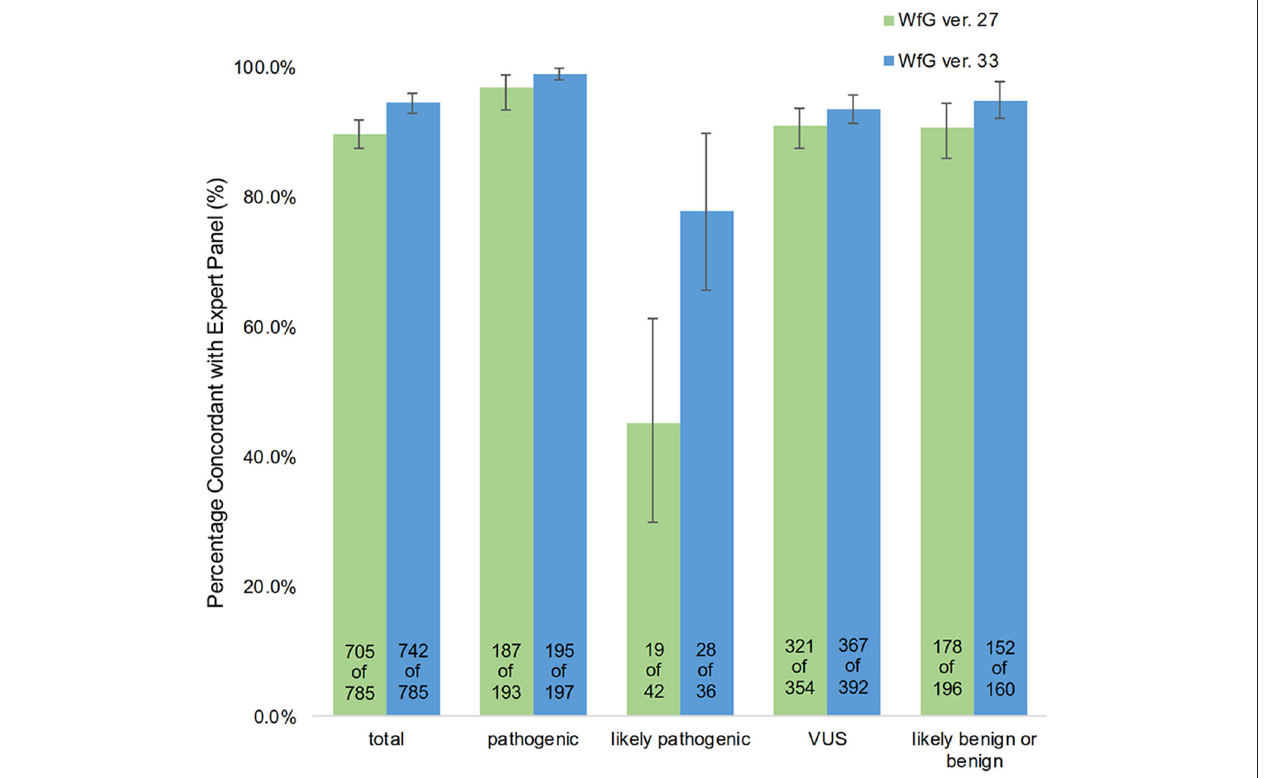
FIGURE 5 | Concordance of pathogenic evaluations of gene mutations between the expert panel and WfG (breakdown of concordant and discordant cases by WfG pathogenic subgroup).